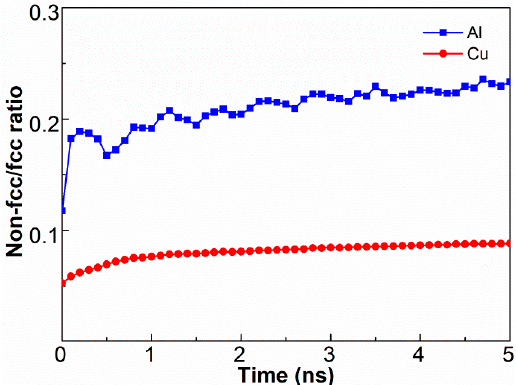
Figure 4. Quantity ratio between the non-fcc and fcc structures in the Al and Cu blocks as a function of welding time.